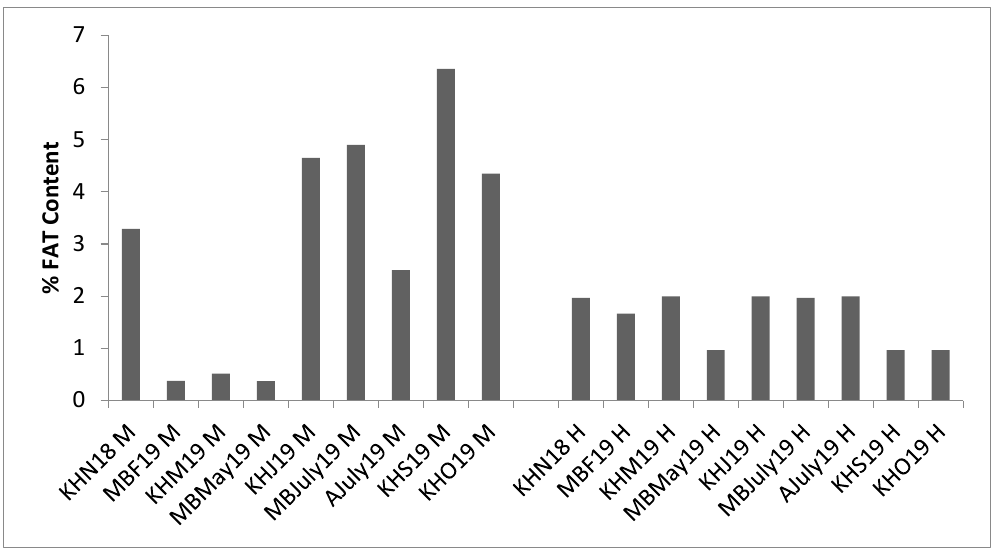
Figure 4. Changes in lipid content (%) for mussel by-products meat (M) and Protamex ® hydrolysates (H). All 9 samples from the three sampling sites, Mulroy bay (MB), Killary harbor (KH) and Ardgroom (A), collected from November 2018 to October 2019, were used for analysis. The lipid content was quantified using AOAC Method 2008.06 with an Oracle Rapid NMR Fat Analyser. Analysis was performed in triplicate (n = 3).